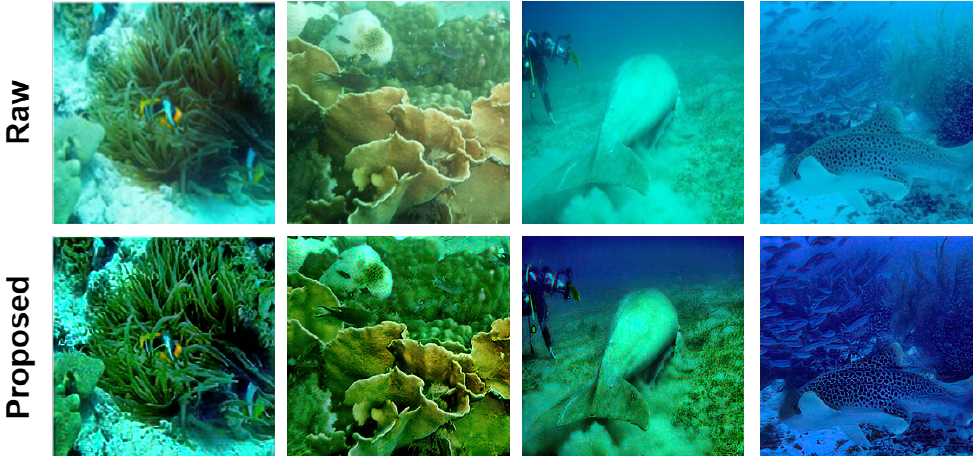
Figure 1. These examples show the visual performance of the proposed technique. Top row: input (hazed) images. Bottom row: the corresponding results produced by the proposed